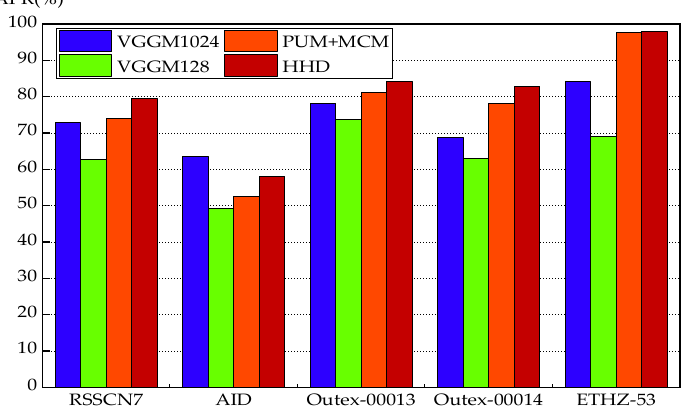
Figure 9. Comparison of the proposed descriptors with the CNN-based schemes over Outex-00013, Outex-00014, RSSCN7, AID and ETHZ-53.